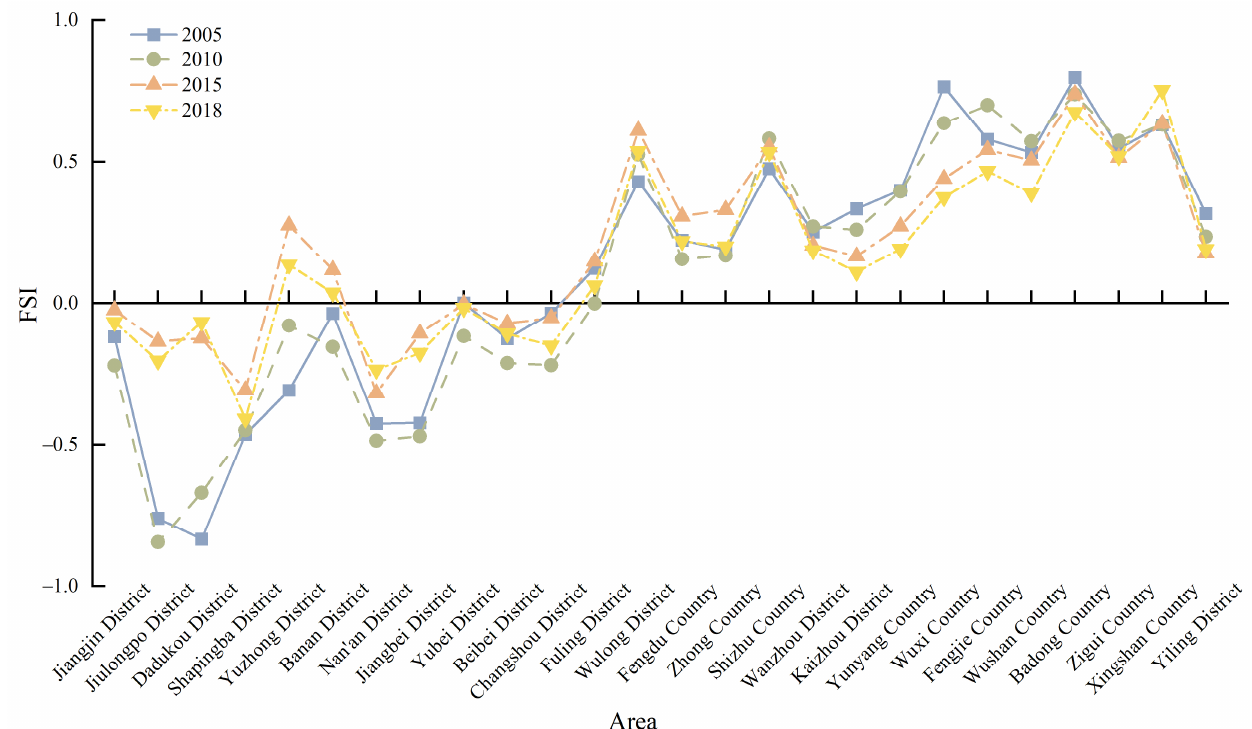
Figure 13. FSI by district and county in the Three Gorges Reservoir Area from 2005 to 2018.